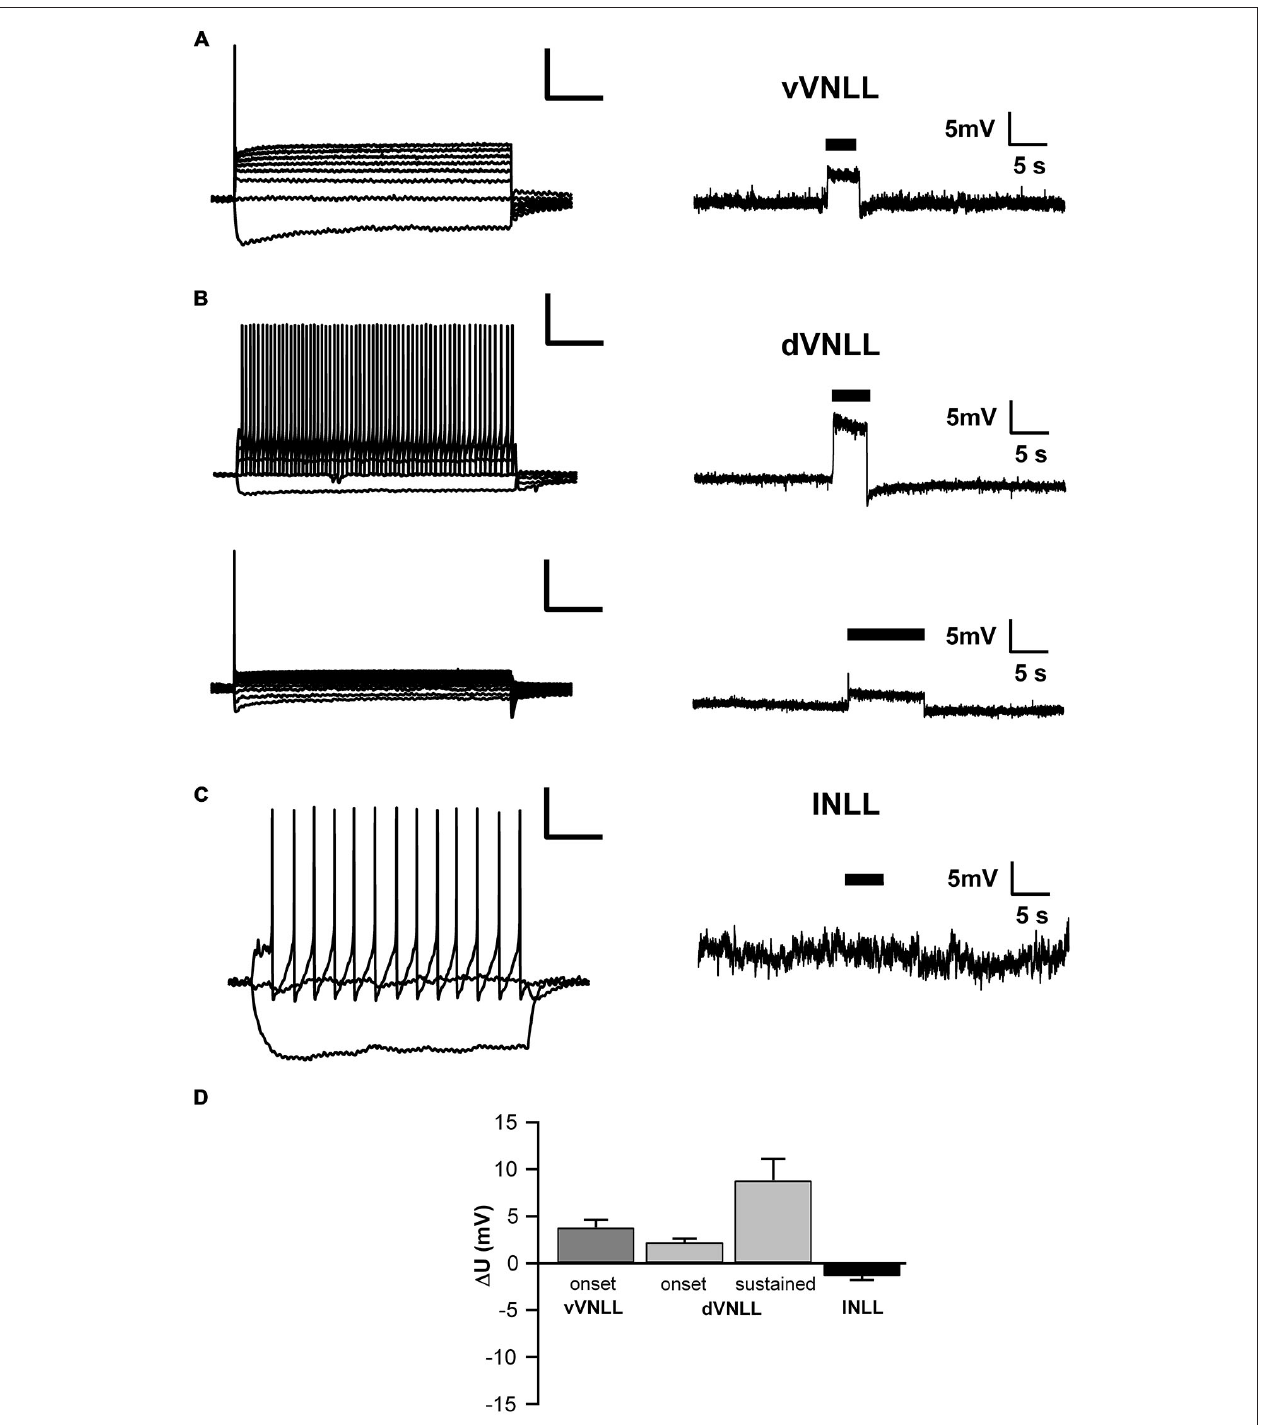
FIGURE 7 | Both vVNLL and dVNLL neurons are inhibitory. (A) Representative voltage trace of a vVNLL neuron to light stimulation (indicated by the black bar). The neuron depolarizes in response to the light pulse. The left panel depicts the corresponding firing pattern of the neuron. (B) Representative voltage traces of an onset-type and a sustained firing dVNLL neuron to light stimulation (indicated by the black bar). Both neurons depolarize in response to the light pulse. The left panels illustrate the corresponding firing patterns of the respective dVNLL neuron. (C) Representative voltage trace of an INLL neuron to light stimulation (indicated by the black bar). The left panel depicts a representative IV curve for INLL neurons. (D) Voltage deflection in response to light stimulation in VNLL and INLL neurons (vVNLL: n = 6, dVNLL: sustained n = 6, onset-type n = 9; INLL: n = 8). Data are obtained from seven mice. Scale bar insets: 200 ms, 20 mV.